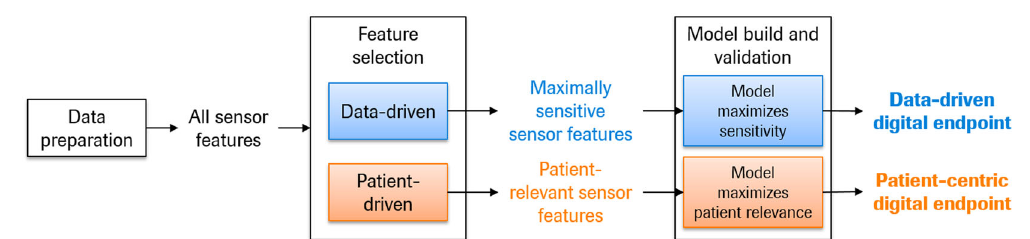
Fig. 1 Procedure to develop digital outcome measures. Signal processing generates sensor features which may be selected in a data-driven or patient-centered procedure to generate maximally sensitive or patient-relevant digital health technology outcome measures,